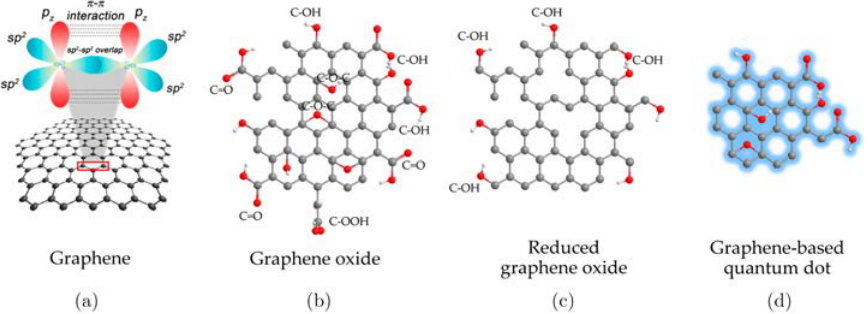
Fig. 1. Structures of graphene-based materials show (a) the pristine graphene (pure-arranged carbon atoms) with sp 2 -hybridized carbon atoms, and the chemically modi¯ed graphene, including (b) GO; (c) rGO and (d) graphene quantum dot (GQD). Reproduced with permission from Ref.